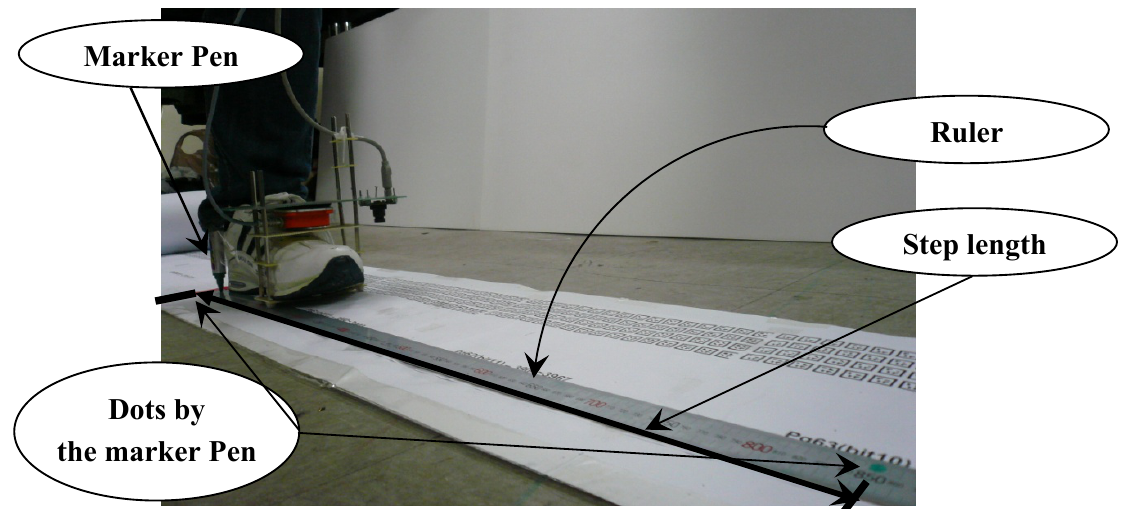
Figure 12. One walking step length